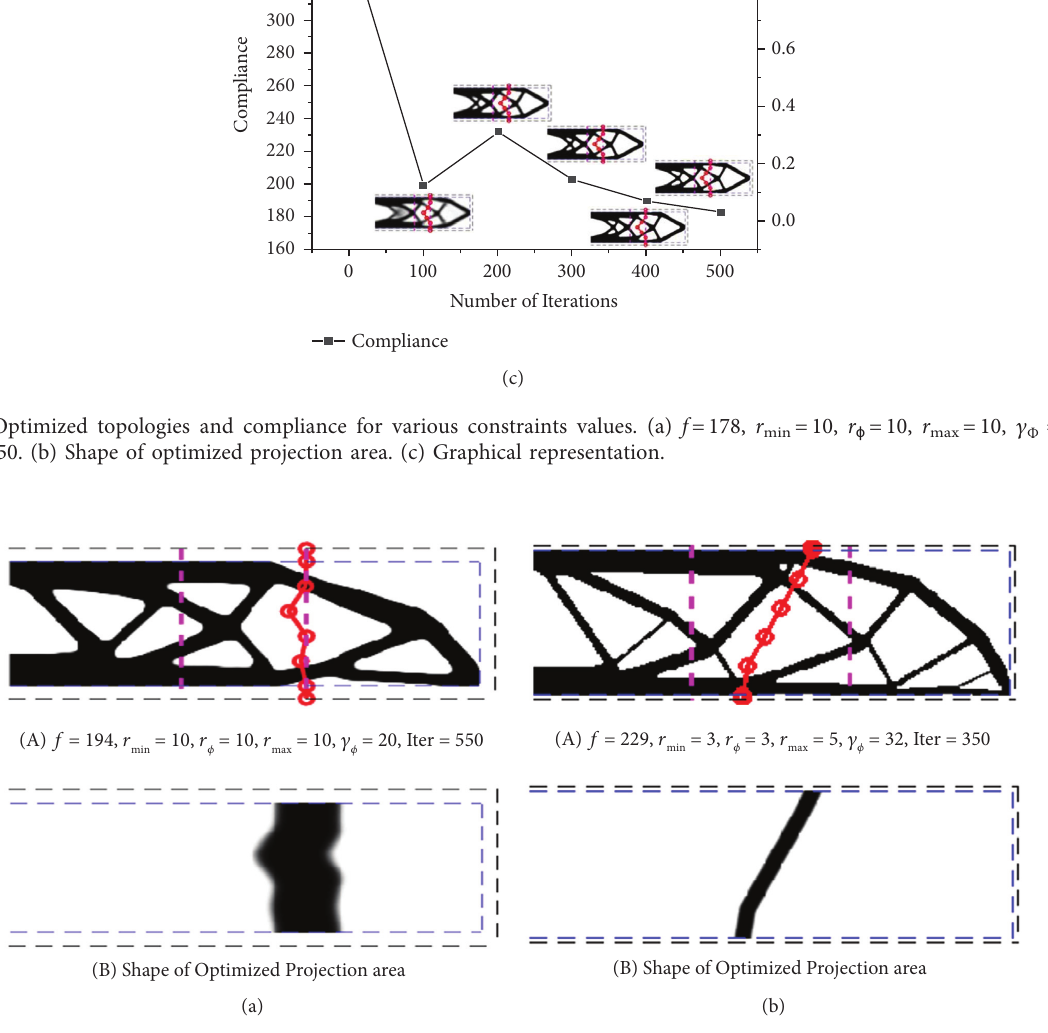
� . 40 , x � 0 . 60. (A) f � 194, r lb ub � . 25 ,x � 0 . 75. (A) f � 229, r lb ub